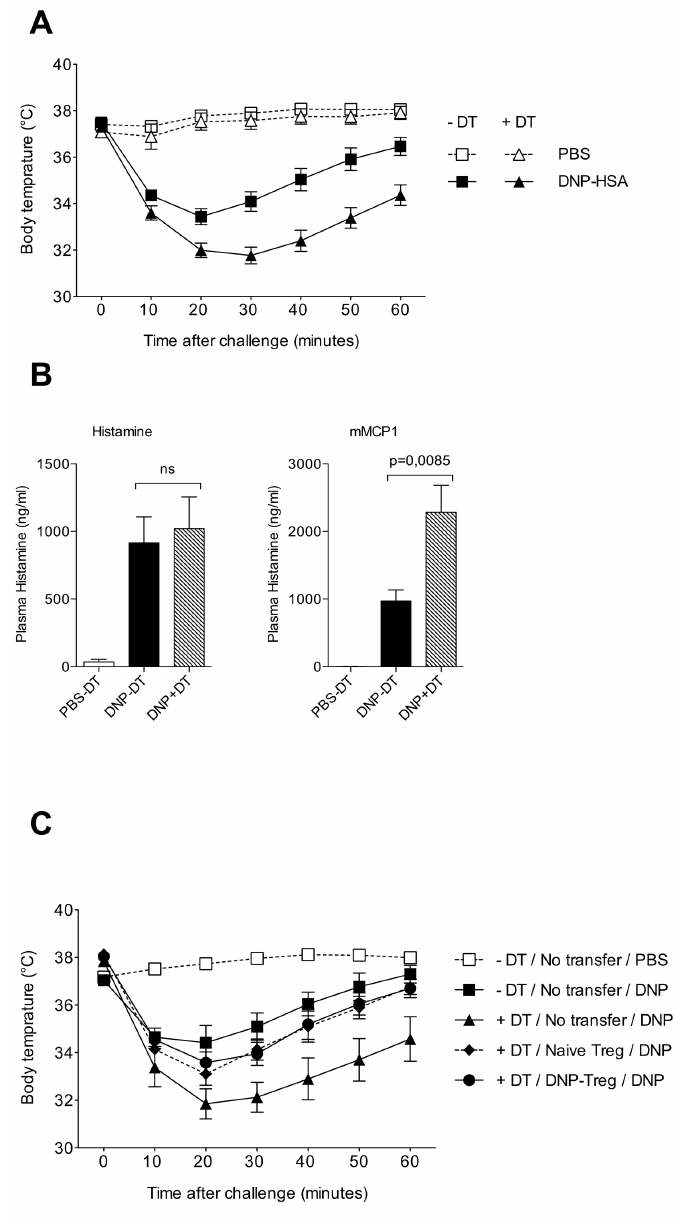
Figure 3. Foxp3 + Treg control the severity and duration of anaphylaxis symptoms. A : DEREG mice were injected with 1µg of DT ( triangles ) or with PBS ( squares ) on day -1, injected with anti-DNP IgE on day 0 and challenged with DNP-HSA ( black symbols ) or PBS ( white symbols ) on day +1. Body temperature was measured at various times after challenge. The data show pooled values from 3 experiments using 4-6 mice/group in each. p** = 0,0007 (2 way ANOVA) for DNP-challenged DEREG with and without DT (p values for each independent experiments are p= 0,032; p= 0,0176 and p=0,0105). B : plasma histamine ( left panel ) and serum mMCP-1 ( right panel ) were titrated in IgE-sensitized DEREG mice that were DT- untreated (black bars) or DT-treated ( grey bars ). IgE-sensitized and PBS-challenged DT-untreated DEREG mice ( white bars ) were used as negative controls. Data show mean ± SEM values (n= 8-10 mice/group) of each factor expressed as ng/ml. Statistical analysis by 2 way ANOVA comparing DEREG with and without DT show significance with p** = 0,0085. C : DT-untreated ( white symbol ) or DT-treated ( black symbols ) DEREG mice were either un-transferred ( black triangles ) or transferred with CD4 + Foxp3 + Treg from either naïve mice ( black diamond ) or from day 6 DNFB-sensitized mice ( black circles ). Mice were passively sensitized with IgE anti-DNP, challenged with DNP-HSA as indicated and body temperature was measured at various times after challenge. Data show mean (± SEM) of body temperature using 5 mice/group. doi: 10.1371/journal.pone.0069183.g003 PLOS ONE |